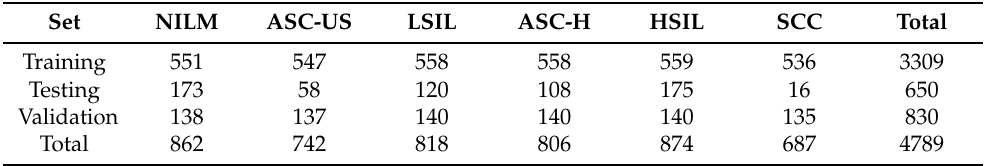
Table 4. The numbers of images from each class after balancing and data augmentation for the training, validation, and testing sets in the six-class